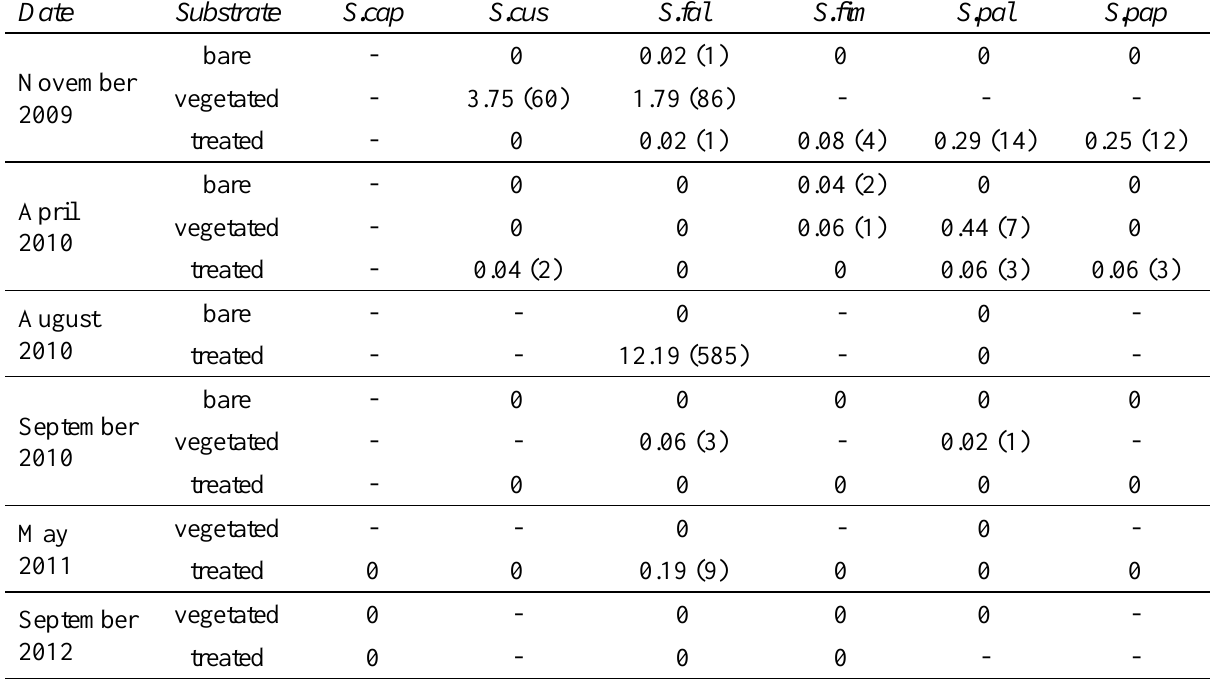
Table 3. Summary of % and (number) of successfully established Sphagnum beads across the field trials on degraded blanket bog (Trial B). Percentages were calculated on the basis of the number of Sphagnum beads initially applied. No data (-) indicates that the species was not used in the trial. Species abbreviations: S.cap